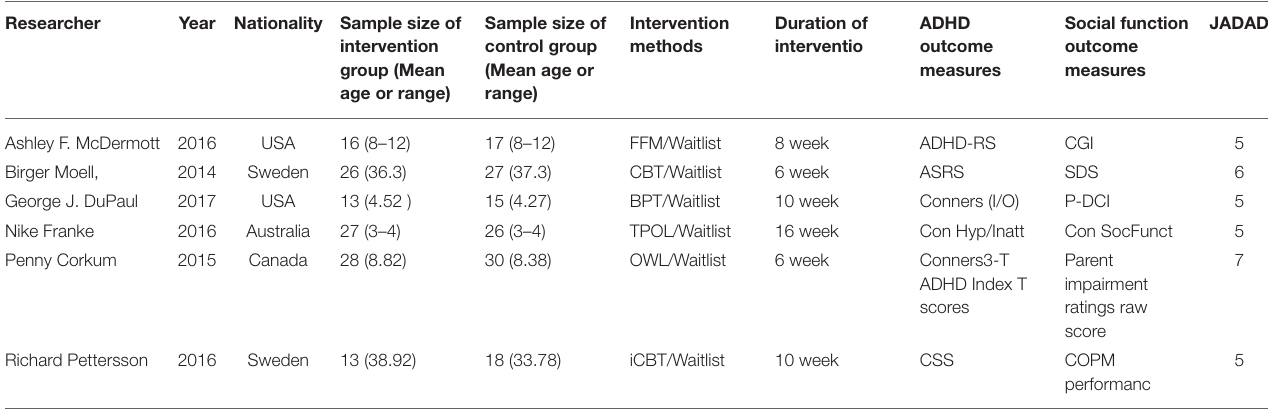
TABLE 1 | Characteristics of the literature included in the study.